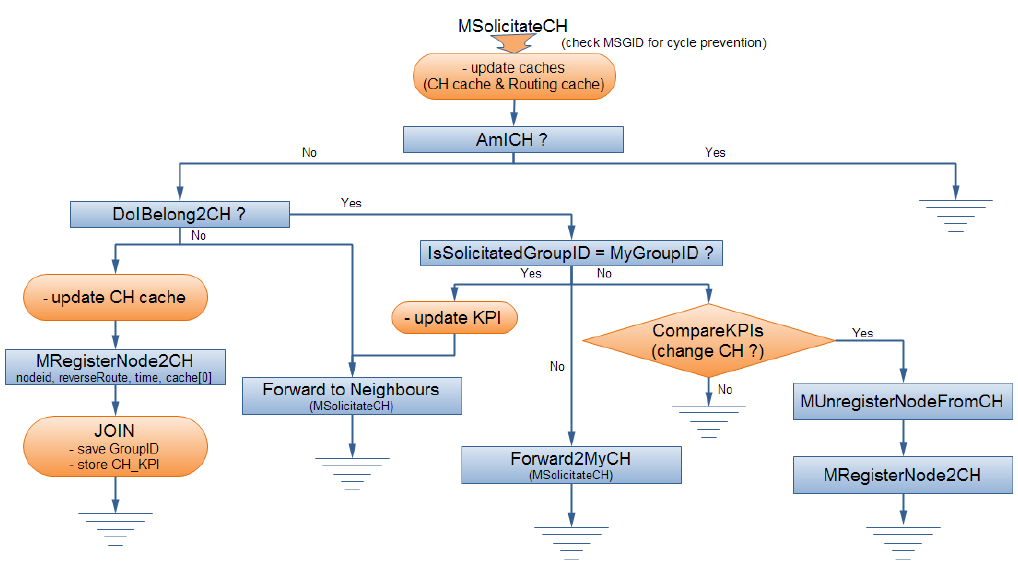
Figure 2. Solicitation Mechanism.